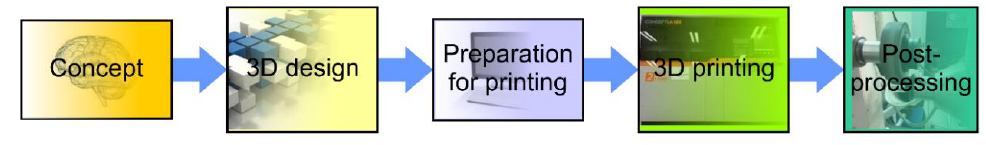
Figure 3. Stages of the tool development.